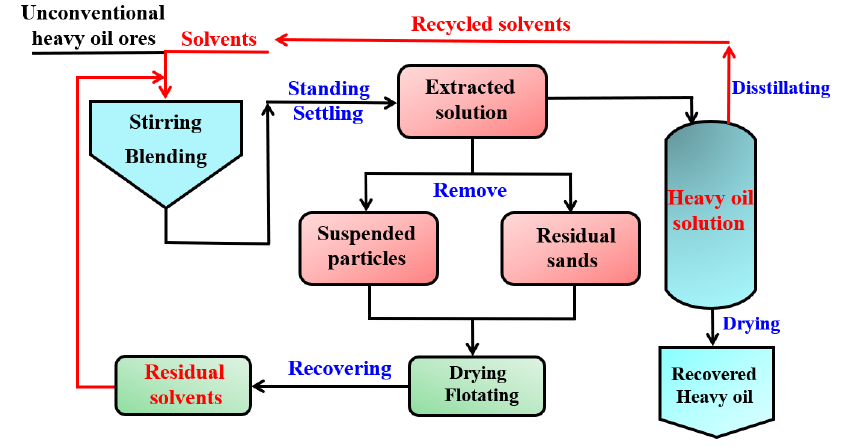
Figure 4. Schematic of the solvent extraction process for recovering heavy oil.